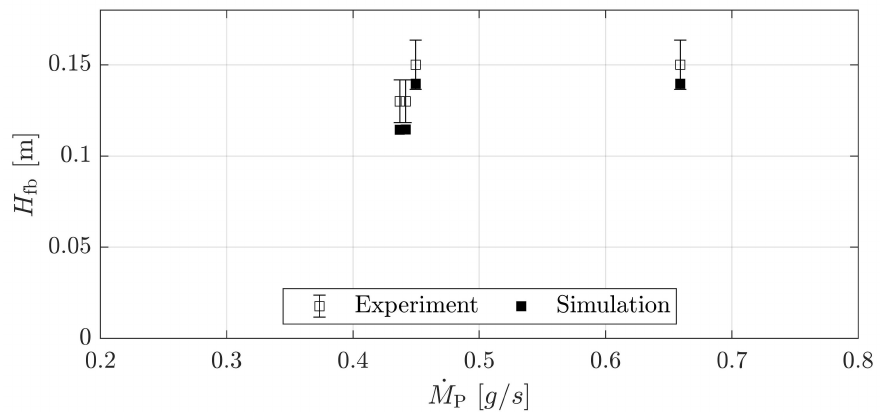
Figure 14. Comparison of operational bed height, measured in the VFB pilot-plant-scale dryer and model predictions for FCC catalyst at an outflow hole height of